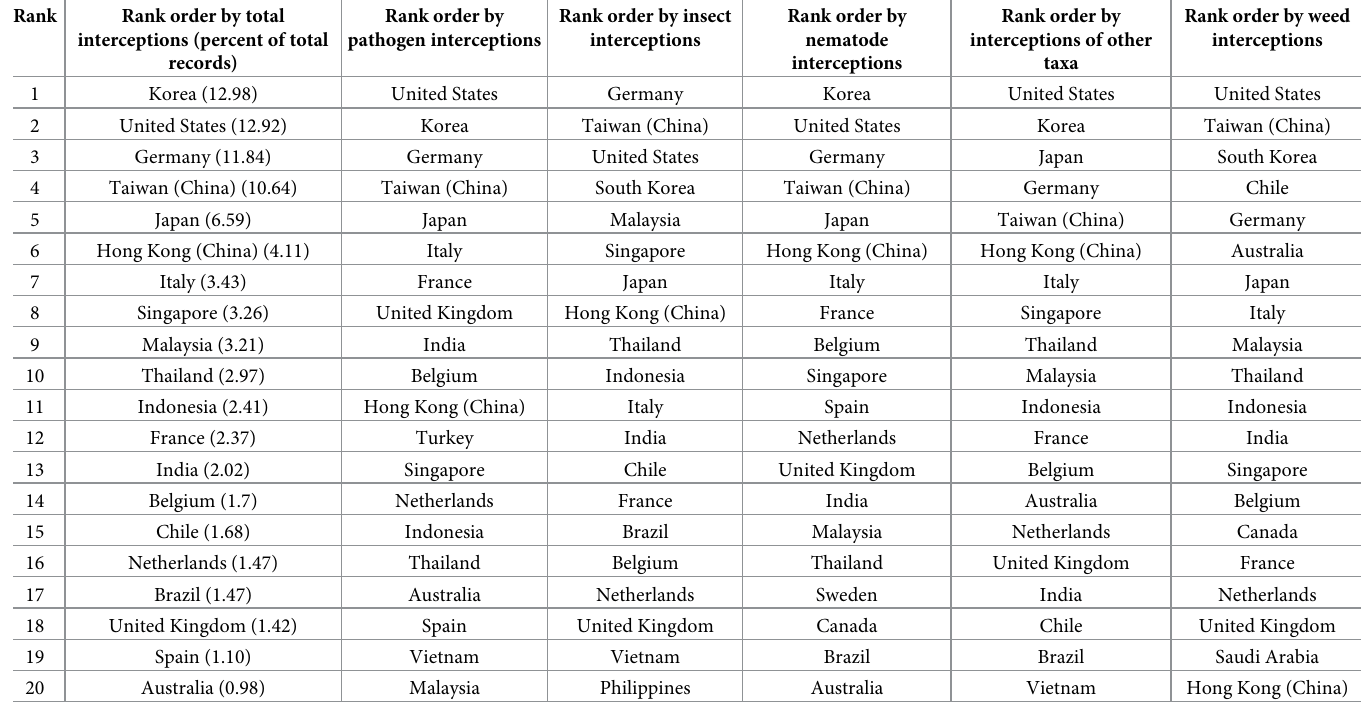
Table 1. Top 20 countries of origin for pest taxa intercepted in China from 2003 to 2016.